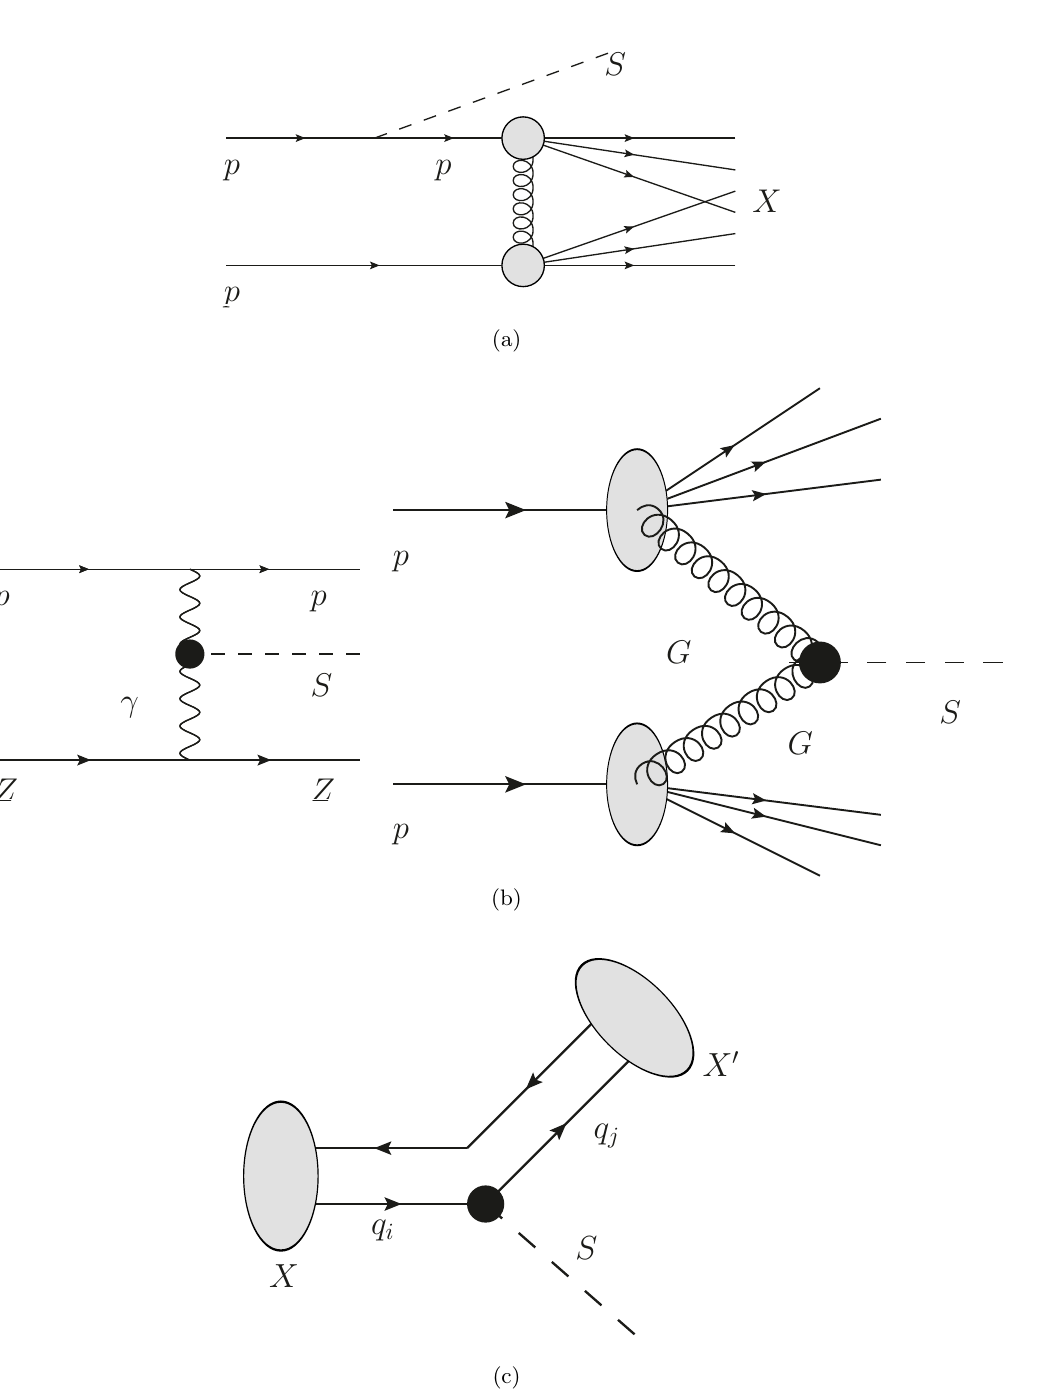
Figure 3 . Example diagrams for the main production channels of a scalar S production in proton- nucleus collisions: proton bremsstrahlung (a), photon and gluon fusion (b), decay of secondary mesons (c).